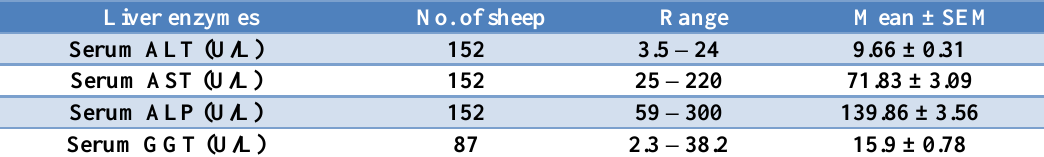
Table, 1: Serum values of ALT, AST, ALP and GGT activities in Awassi sheep (M±SE) Liver enzymes No. of sheep